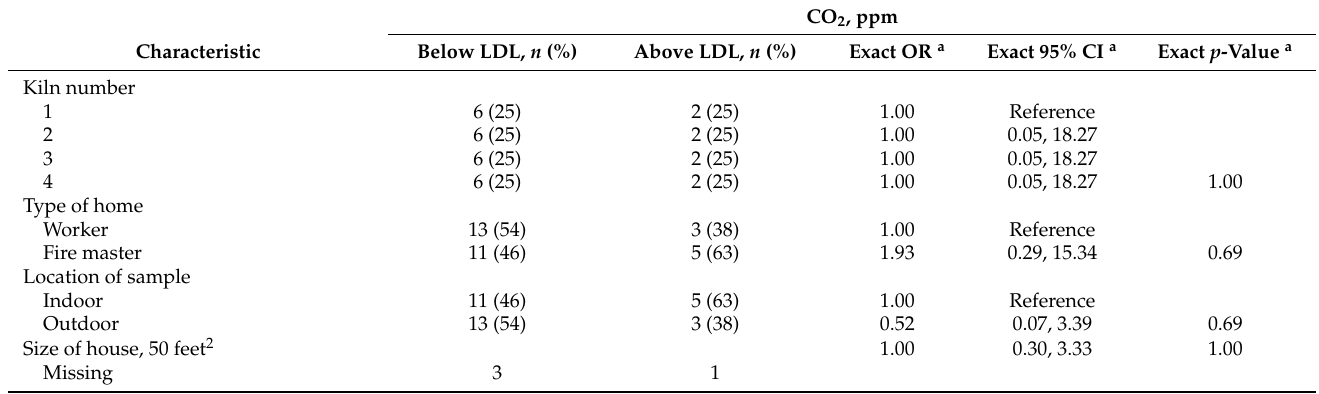
Table 3. Associations between characteristics and having CO 2 air concentrations measured inside and outside homes above the LDL at brick kilns in Bhaktapur, Kathmandu Valley, Nepal, May 2018. CO 2 ,